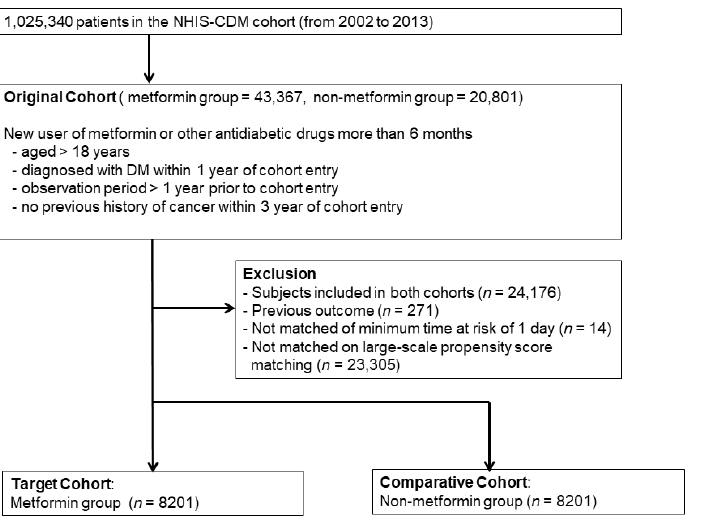
Figure 1. Flow chart in the analysis of colorectal cancer incidence. NHIS-CDM, National Health Insurance Service-Common Data Model; DM, diabetes